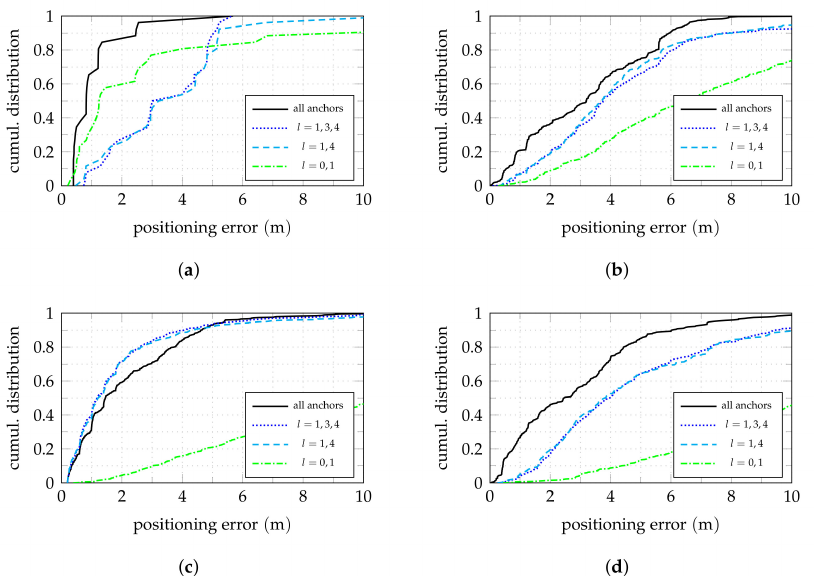
Figure 9. Cumulative absolute error distributions for the four aisles. The anchor configurations used in Figure 8 are shown. Note that in the previous shelf-wise consideration shelves with a high number of nodes do not stand out in particular, while here all of them contribute individually. The curves for all anchors are the same as in Figure 7a. ( a ) Aisle 0. ( b ) Aisle 1. ( c ) Aisle 2. ( d ) Aisle